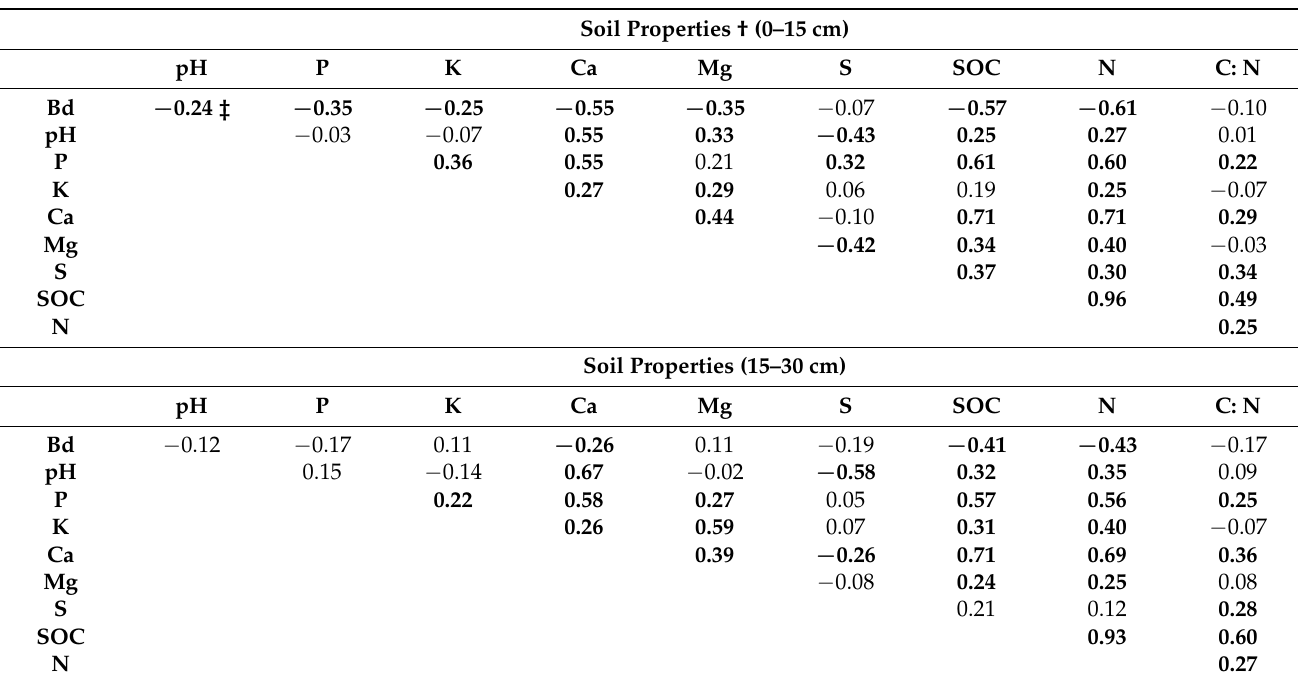
Table 5. Pearson’s correlation coefficients between soil properties at the 0–15 cm and 15–30 cm soil depth in a 17-year agroforestry site in Fayetteville,